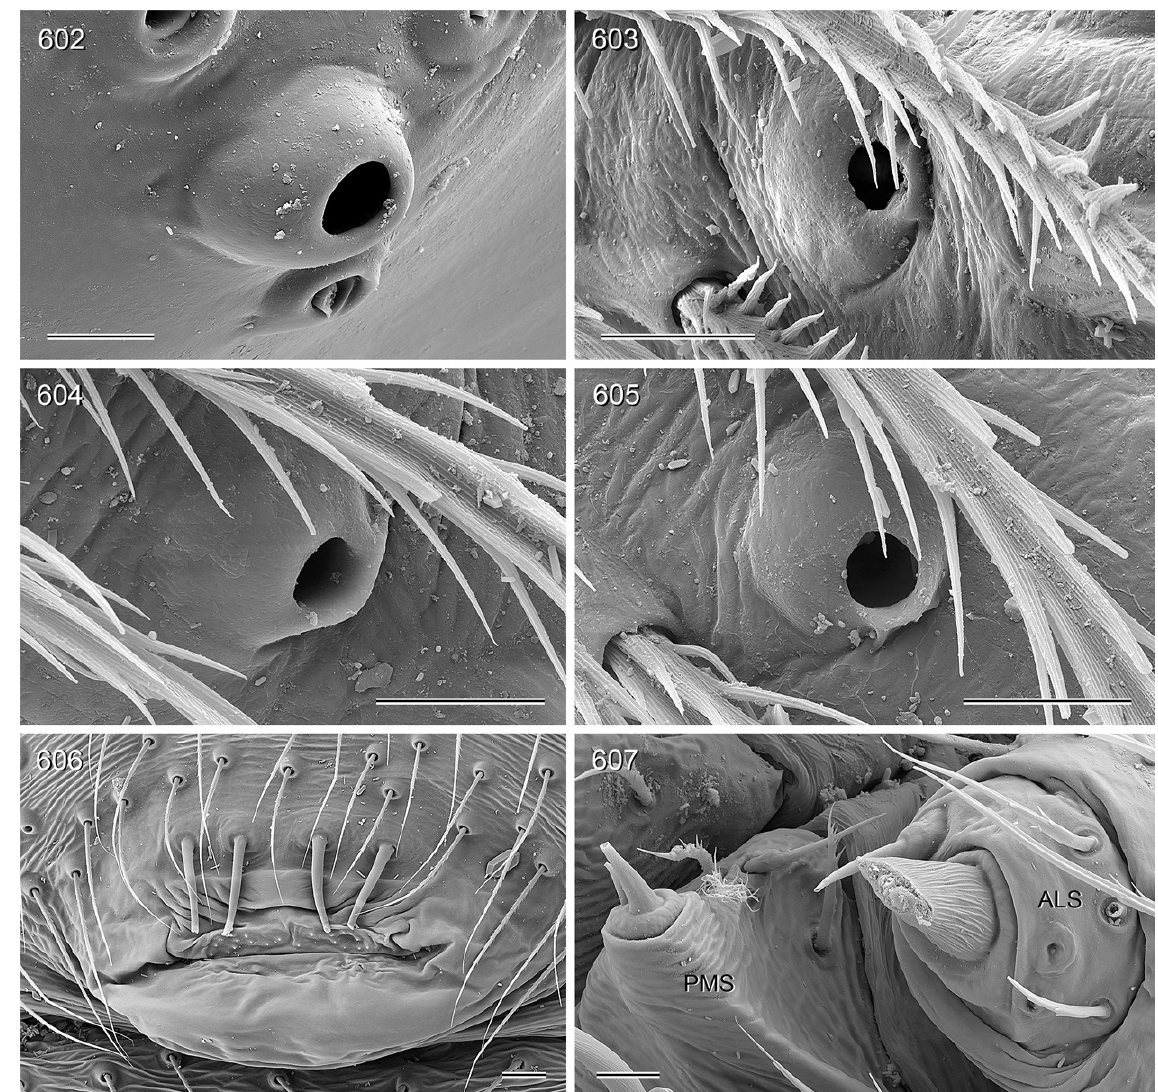
Figs 602–607. Crossopriza semicaudata (O. Pickard-Cambridge, 1876); male and female from Chad, Bardaï (MRAC 132959). 602 . Male palpal tarsal organ. 603–605 . Tarsal organs on female tarsi 1, 2, and 4. 606 . Male gonopore. 607 . Male spinnerets. Scale bars: 602–605, 607 = 10 µm; 606 = 20